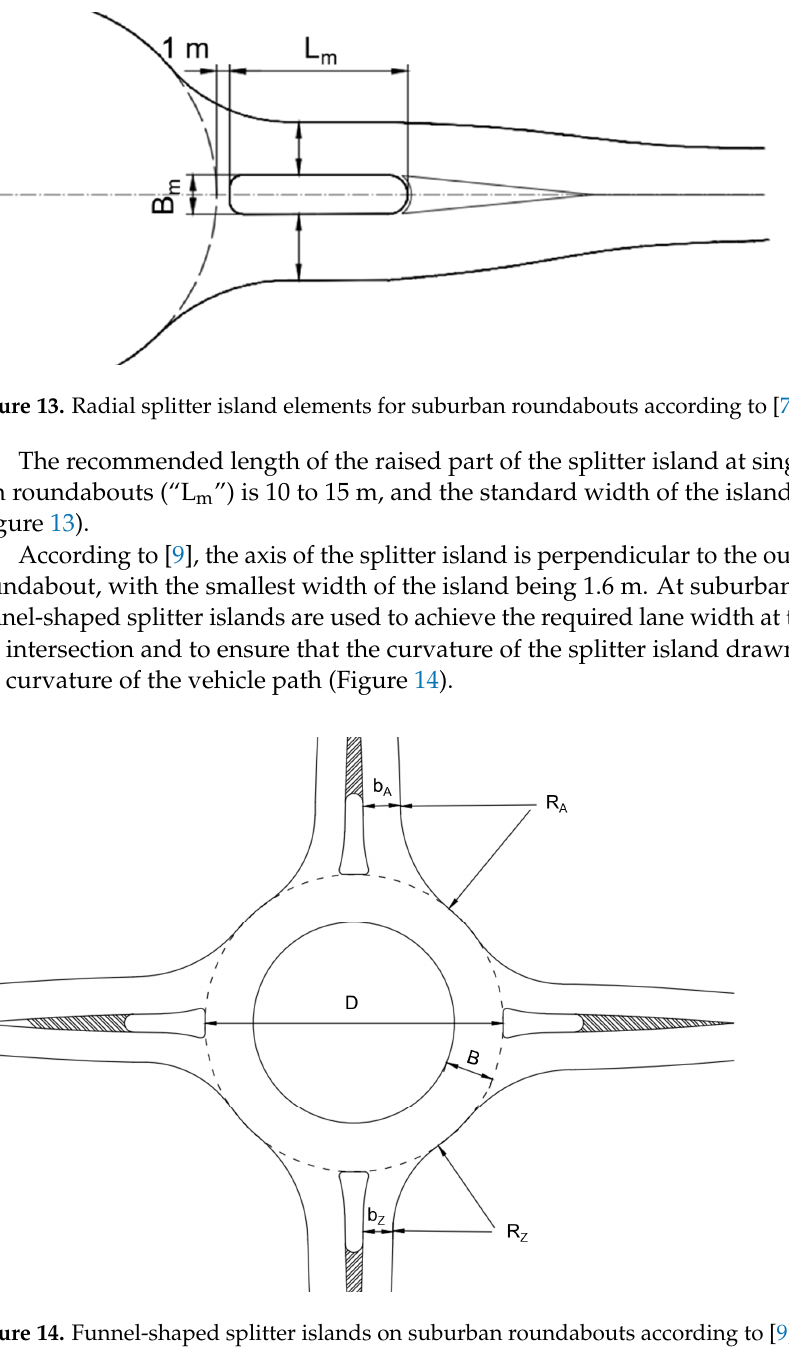
According to [10], the shape of the splitter island is conditioned by the desired level of